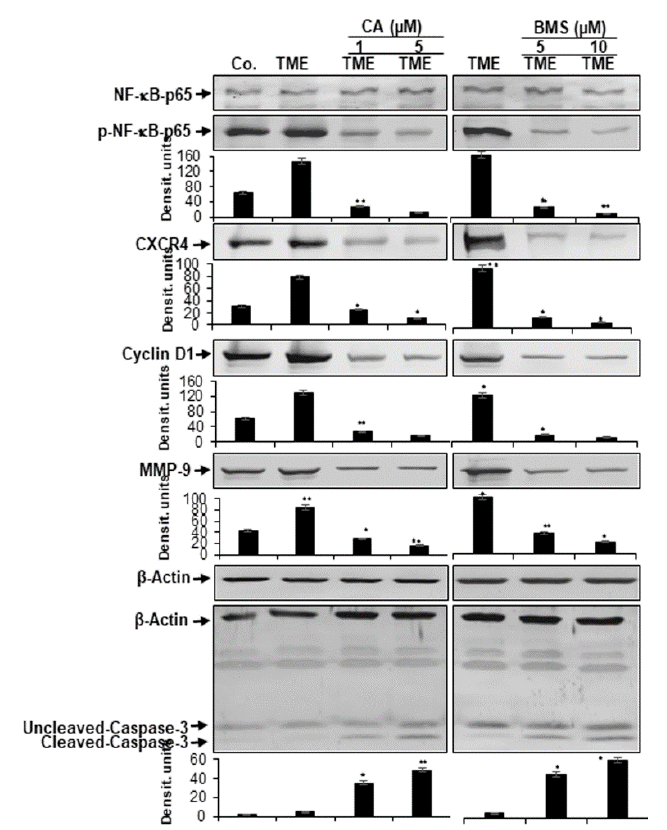
Figure 5. E ff ect of Calebin A (CA) or specific IKK inhibitor BMS-345541 on activation of NF- κ B and NF- κ B-regulated gene end-products in CRC cells: Serum-starved HCT116 cells in alginate cultures from multicellular pro-inflammatory TME cultures were treated as described in Materials and Methods. Immunoblotting of whole-cell lysates from HCT116 was performed for anti-p65-NF- κ B, anti-phospho-p65-NF- κ B, anti-MMP-9, anti-CXCR4, anti-Cyclin D1, and anti-cleaved-caspase-3. β -actin served as an internal loading control in all experiments. For densitometric evaluation, results are compared to control and p < 0.05 (*), p < 0.01 (**) were considered statistically significant.